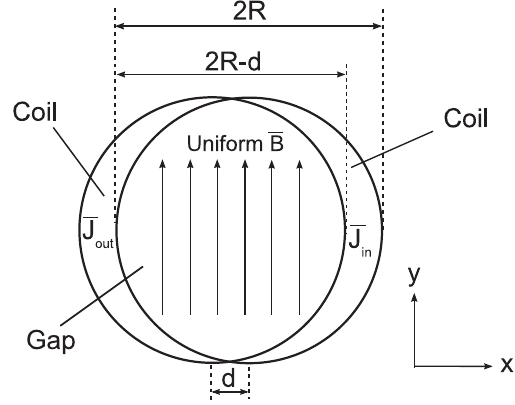
FIG. 9. Schematic diagram of the front view of the dipole. The dipole ’ s length extends in the z direction. The current of the two sets of coil flow into and out of the paper,